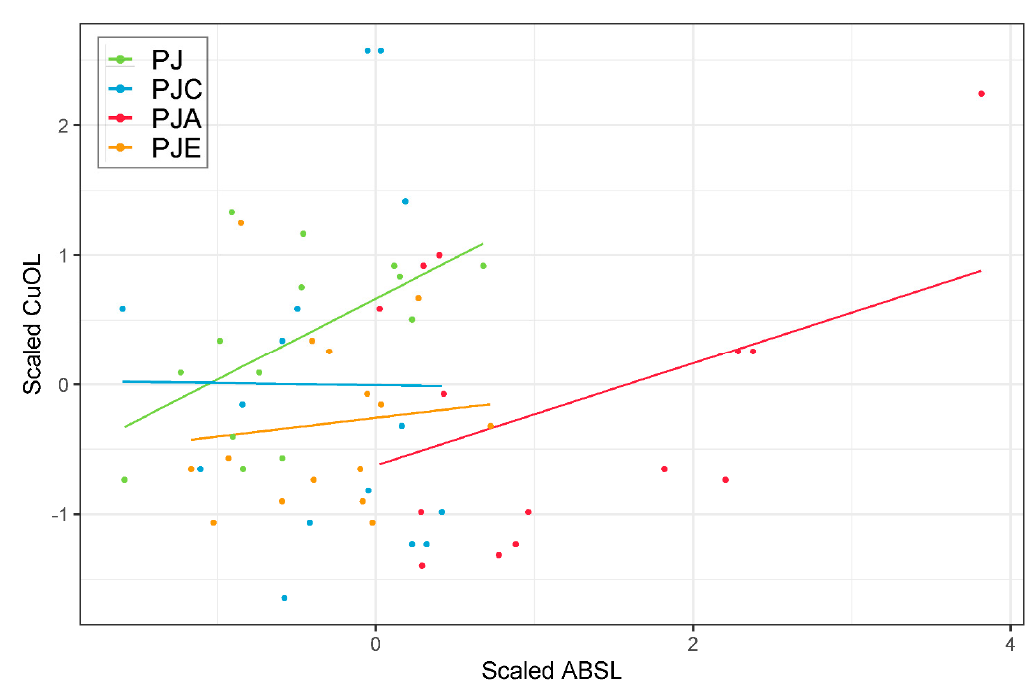
Figure 3. Scatterplot between scaled data of ABSL and CuOL. Observations are colored according to the different plots, and simple regression lines have been added to aid a general visualization of the relationship between data.